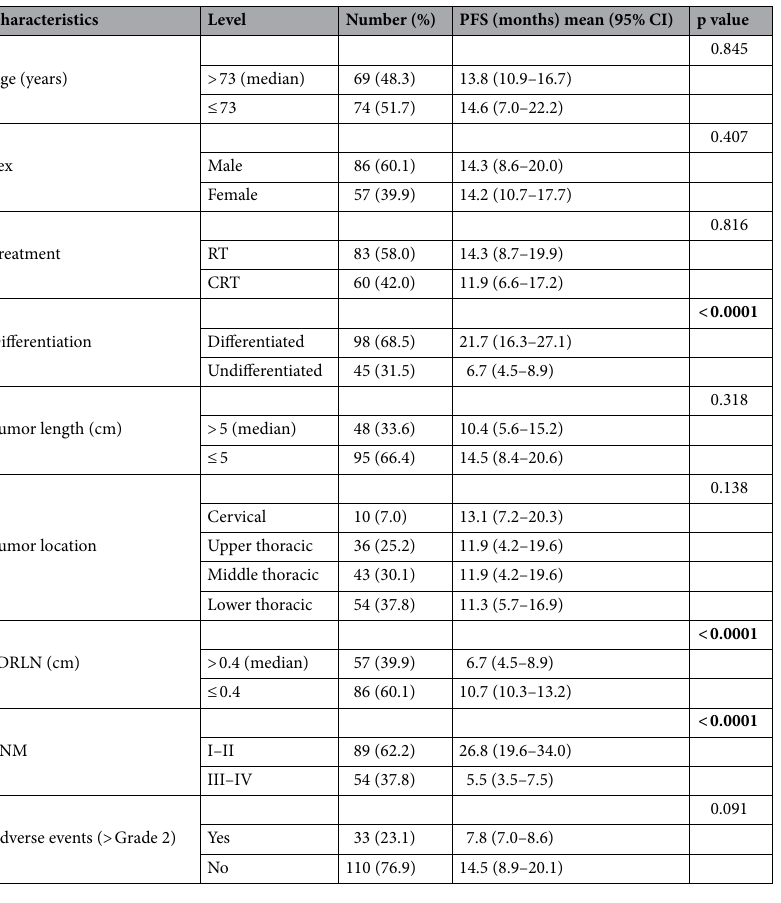
Table 1. Baseline clinicopathological characteristics of patients with ESCC and log-rank test. RT radiotherapy, CRT chemoradiotherapy, SDRLN short diameter of residual lymph node. The bold entries represent statistically